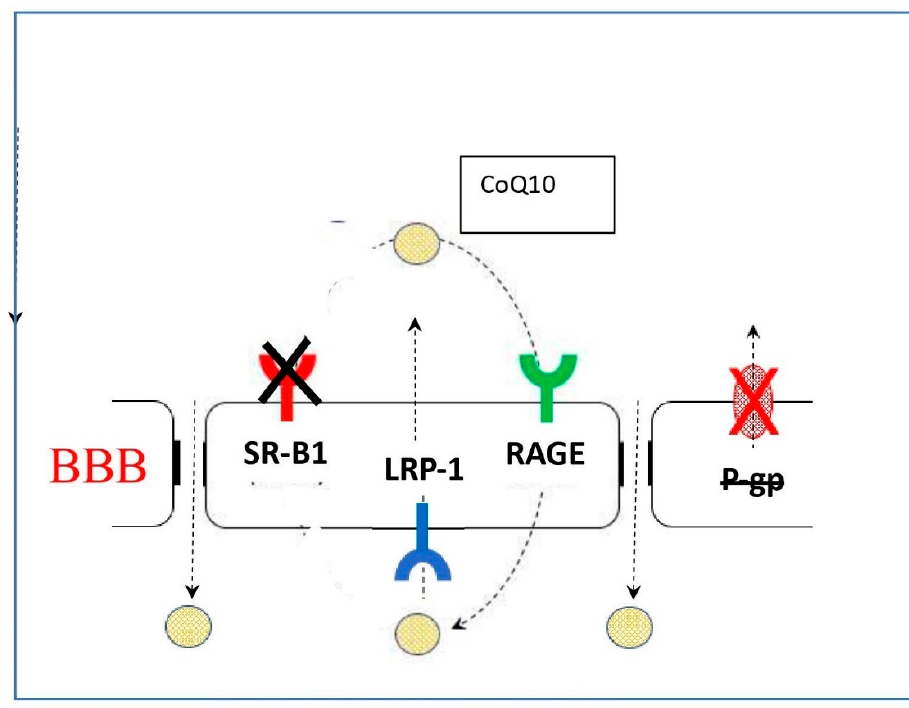
Figure 1. The NET direction of transport reverses with CoQ 10 deficiency, delivering CoQ 10 toward brain. BBB: Blood–brain barrier; SR-B1: Scavenger receptor B1; LRP-1: Low Density Lipoprotein related protein -1; RAGE: Receptor Advanced Glycation End-products; P gp: P-glycoprotein